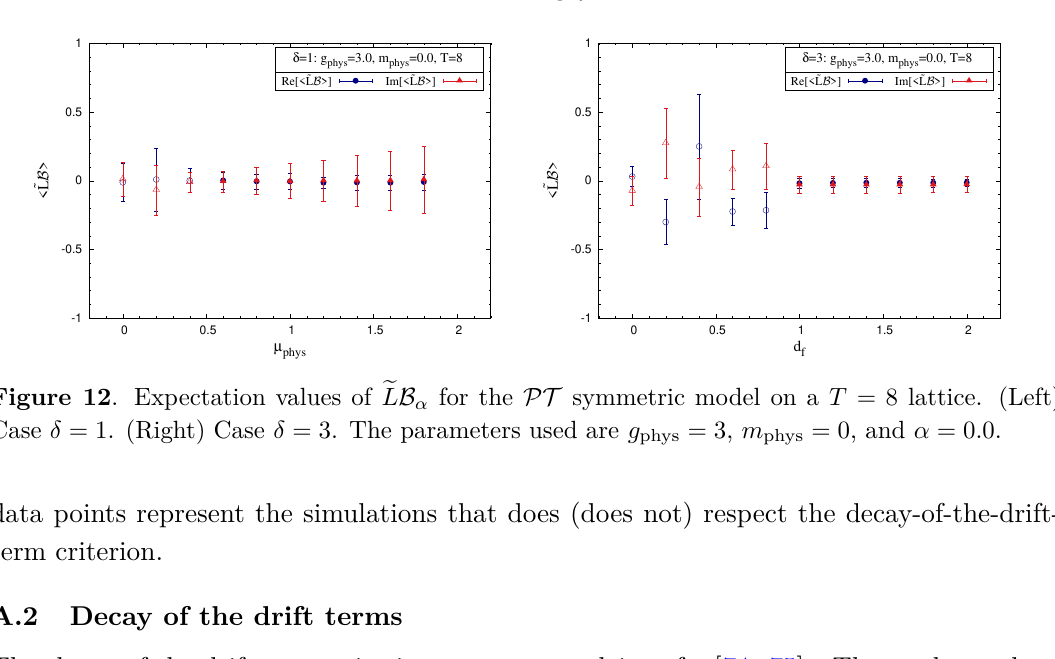
Table 7 . Expectation value of e L B α for the PT -symmetric potentials given in eq. (4.9) with δ = 2 and 4. The simulation parameters used are β = 1 , g phys = 0 . 5 , and α = 0 .